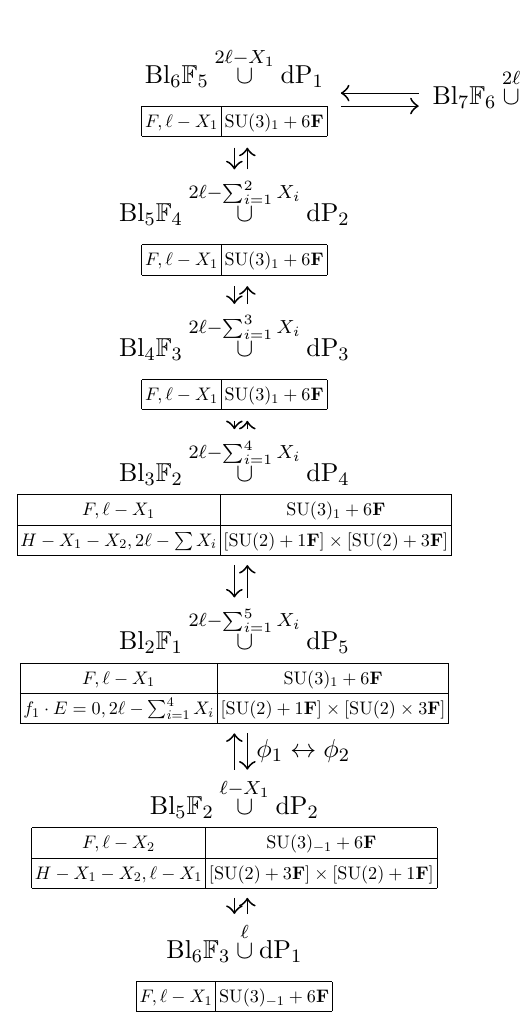
Figure 15. M = 7 geometries,